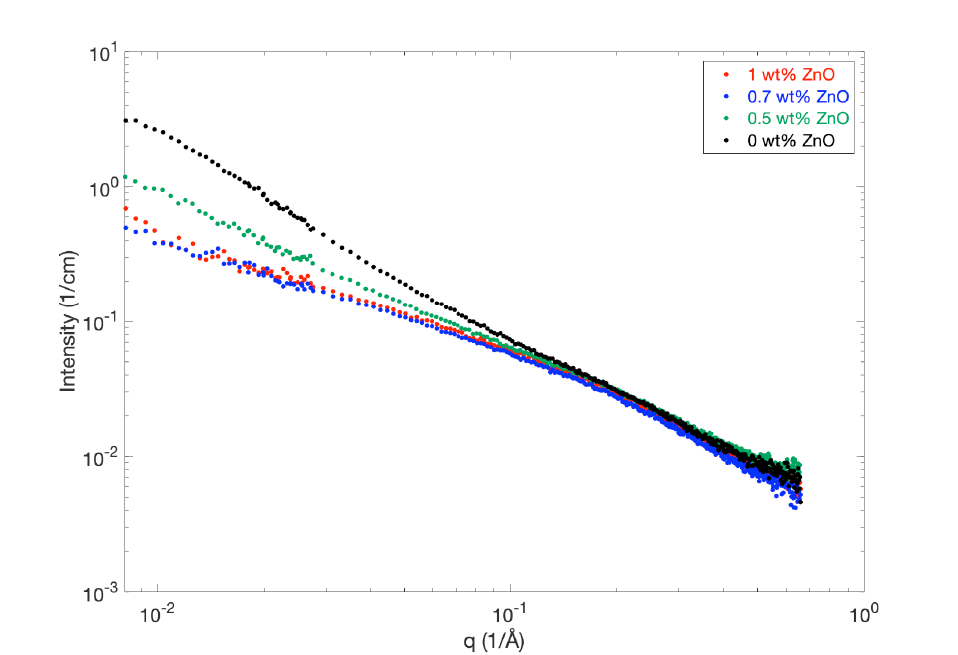
Figure 6. SAXS patterns for 4 wt % MCC dissolved in 8 wt % NaOH with/without a varying content of